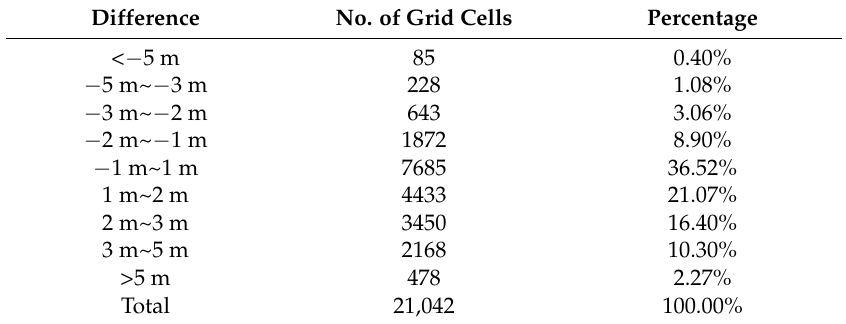
Table 5. The difference statistics between two DSMs generated from thermal images and airborne LiDAR.